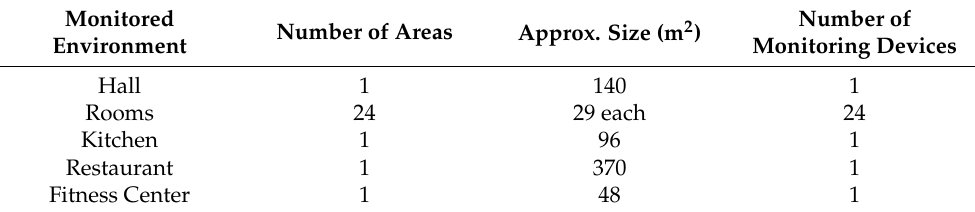
Table 1. Detailed presentation of the environments monitored, in terms of number of areas, approxi- mate size and number of devices